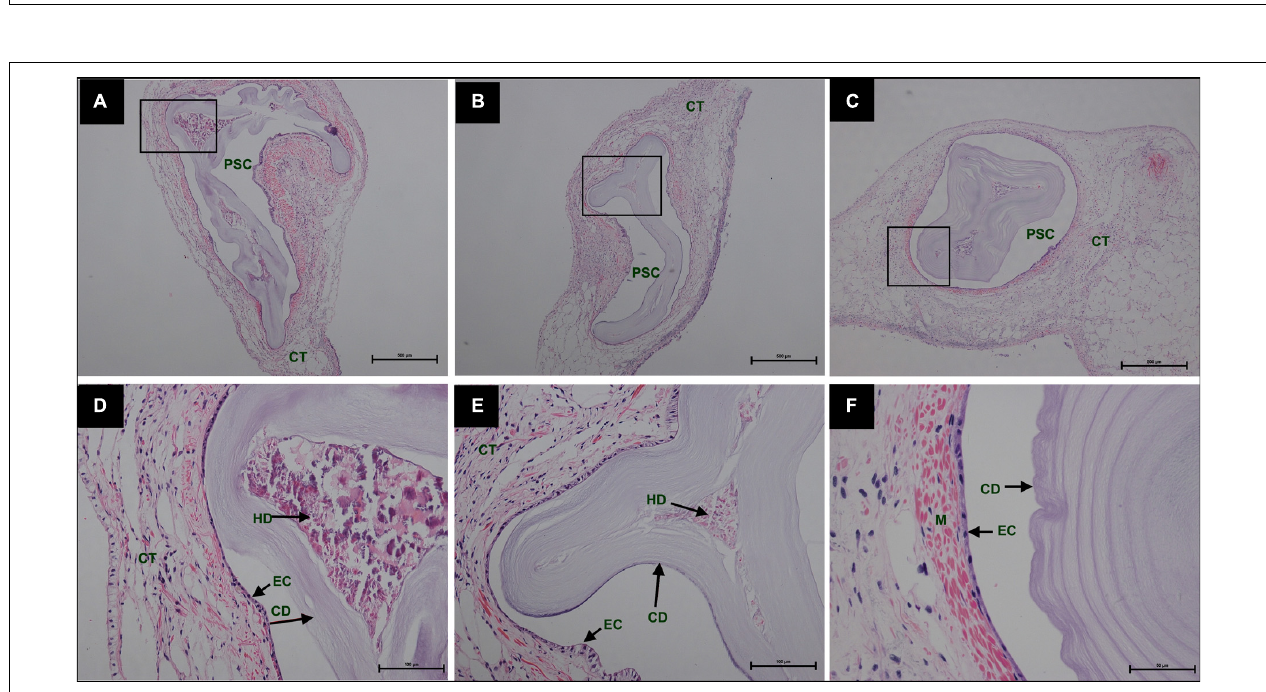
FIGURE 4 | Histology of pearl sac development in Hyriopsis cumingii on days 15, 18, and 21 after grafting by Haematoxylin-Eosin stain. (A–C) are overview of developmental pear sac in the pallial mantle of host mussel on days 15, 18, and 21, respectively. The black boxes indicate the areas shown at higher magnification. (D–F) are the high magnification views of partial area of pearl sac in panels (A–C) , respectively. The abbreviations indicate PSC, pearl sac cavity, CT, connective tissue, EC, epithelial cell on pearl sac, CD, CaCO 3 crystals deposition, HD, hemocyte debris. Scale bars are 500 µ m in panels (A,B) , 100 µ m in panels (C,D) .